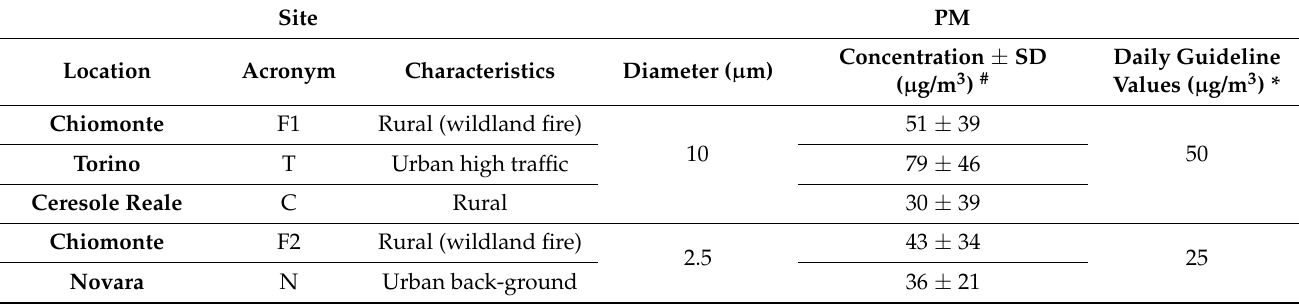
Table 1. Characteristics and PM concentrations of the sampling